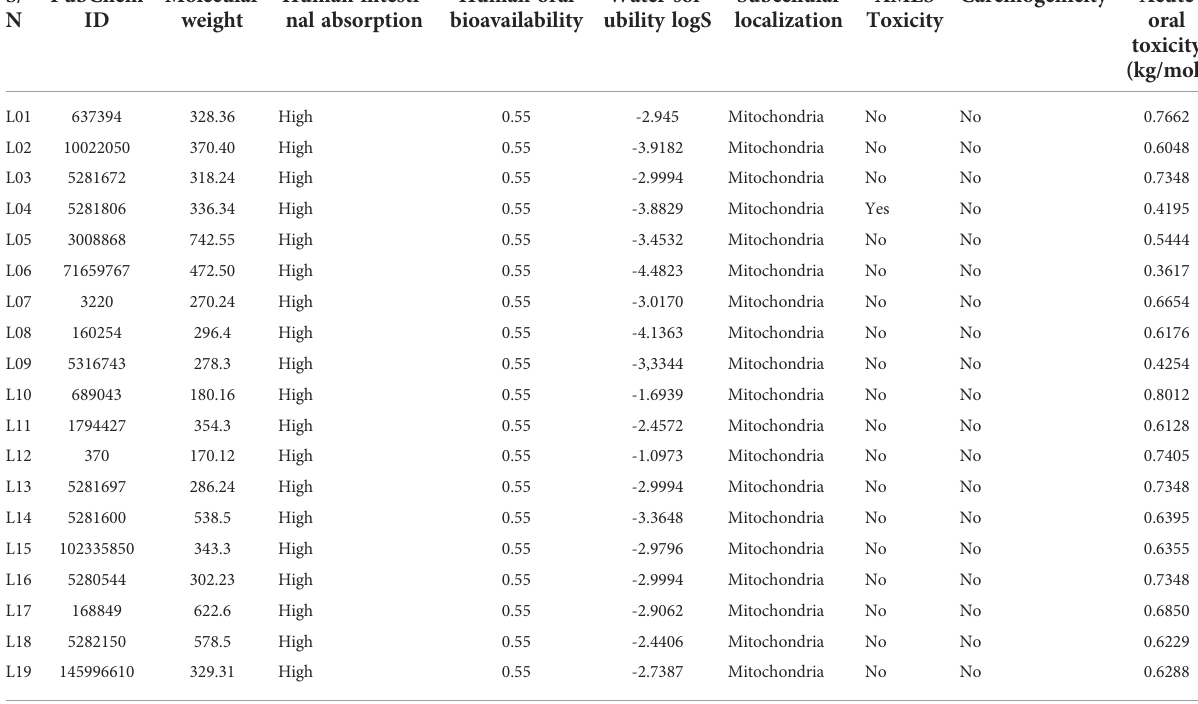
TABLE 4 ADMET properties and aquatic and non-aquatic toxicity